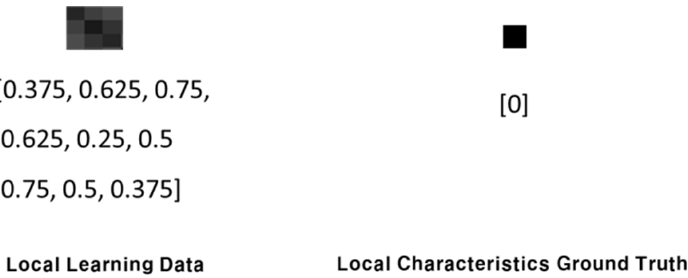
Figure 6. The example of local learning data based on local characteristics and local characteristics